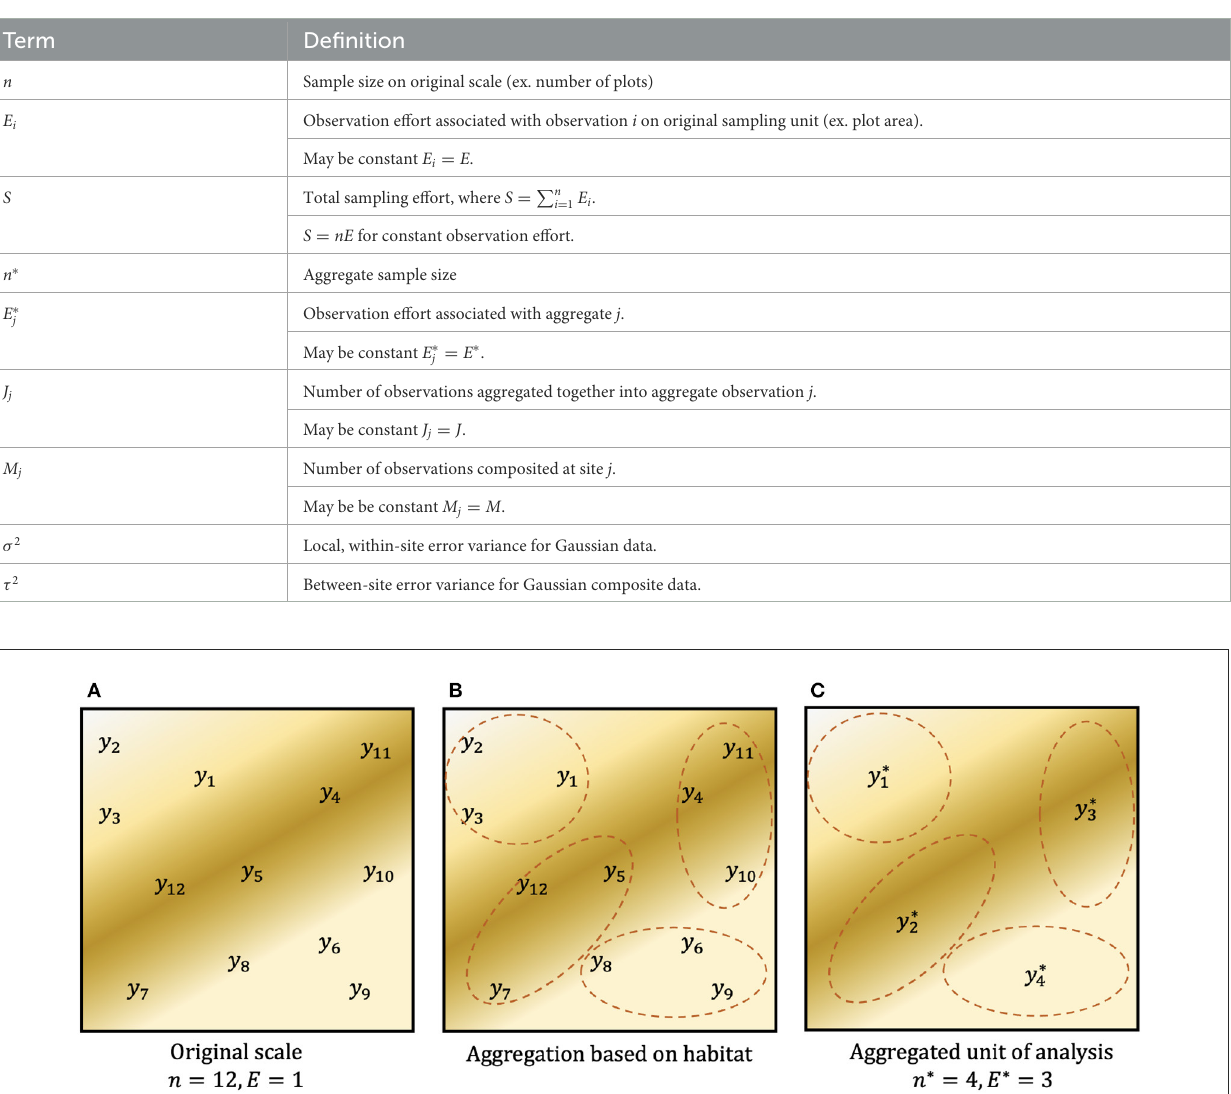
TABLE 1 Terms and definitions related to few-large vs. many-small and aggregation concepts.